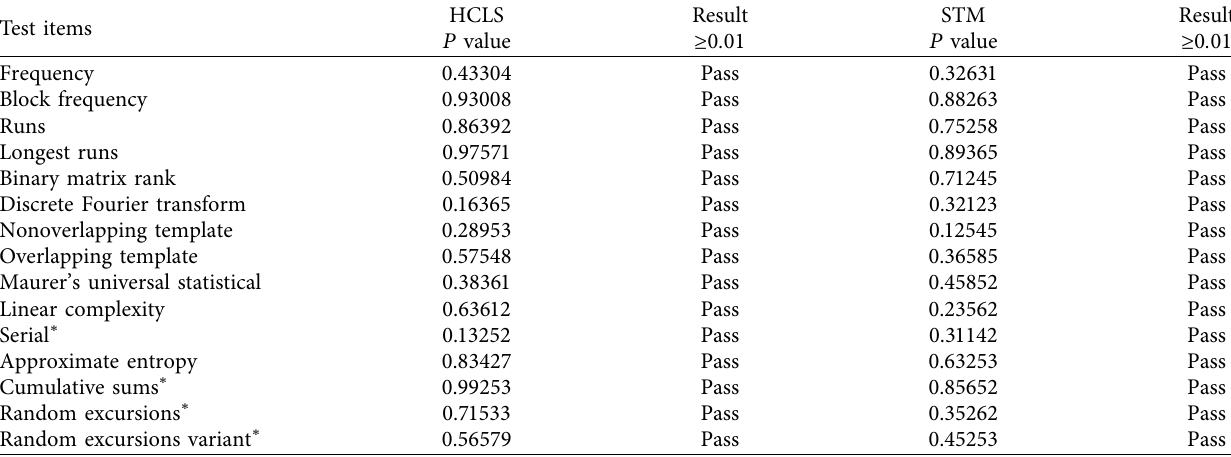
Table 7: NIST SP800-22 test results.